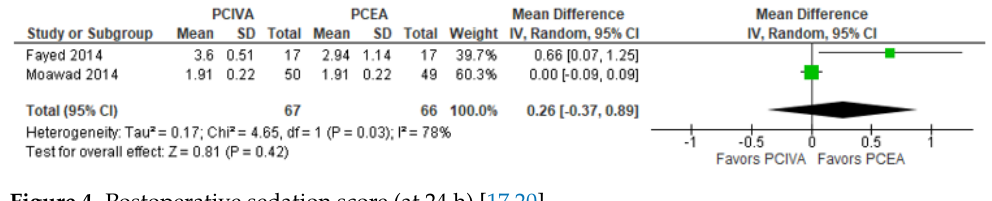
Figure 4. Postoperative sedation score (at 24 h) [17,20].